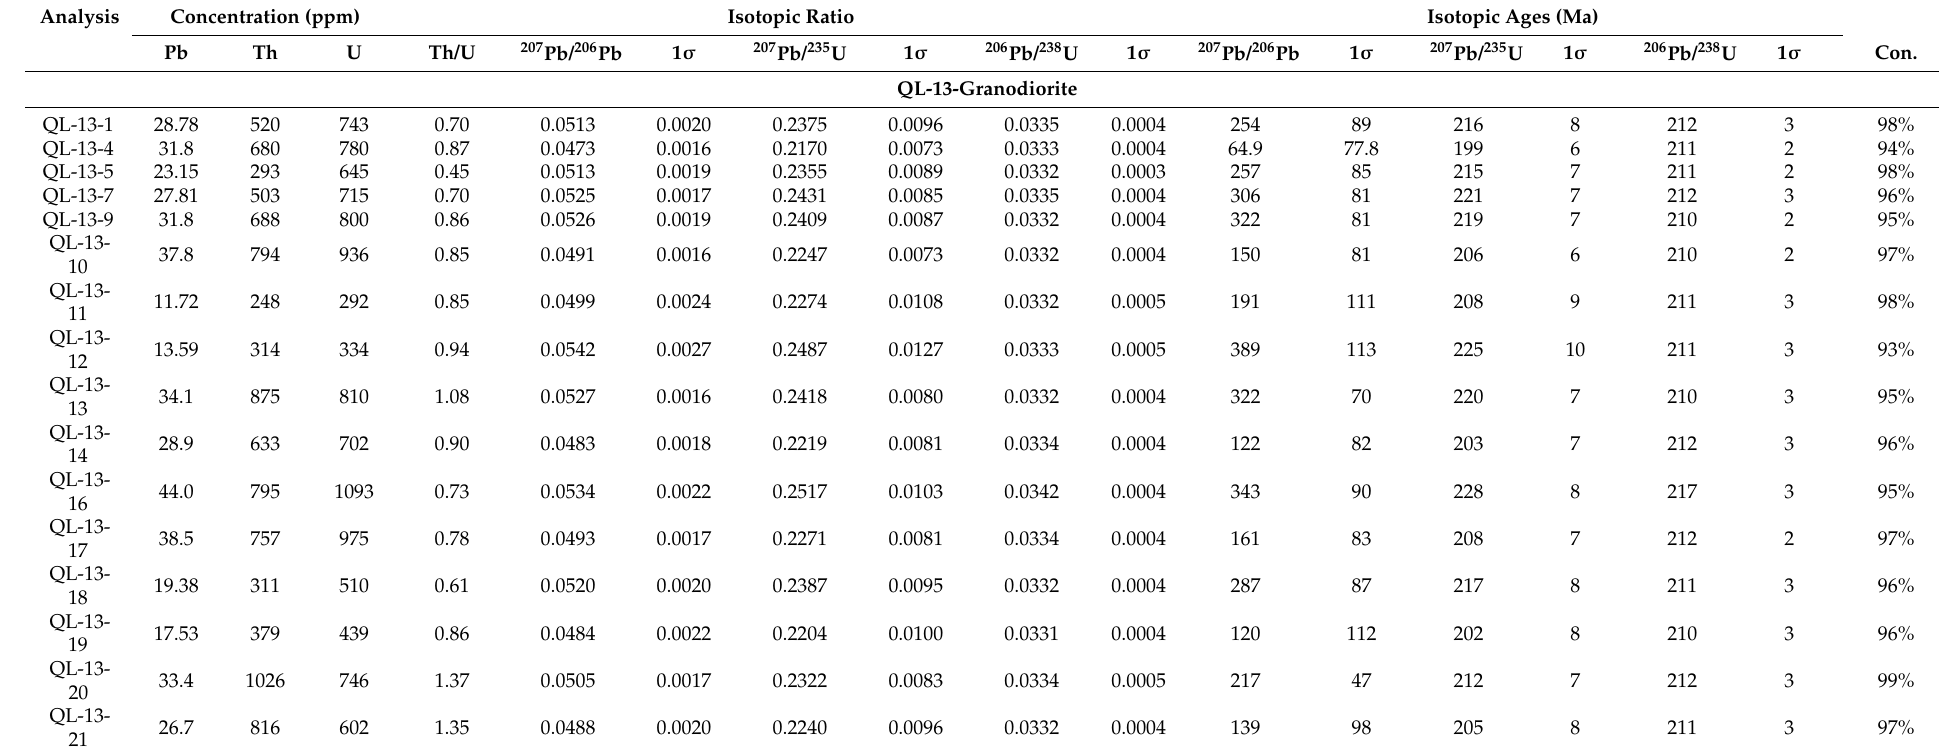
Table 2. LA-ICPMS U-Pb zircon isotope ratios of the granite porphyry from the Qinglingou Au